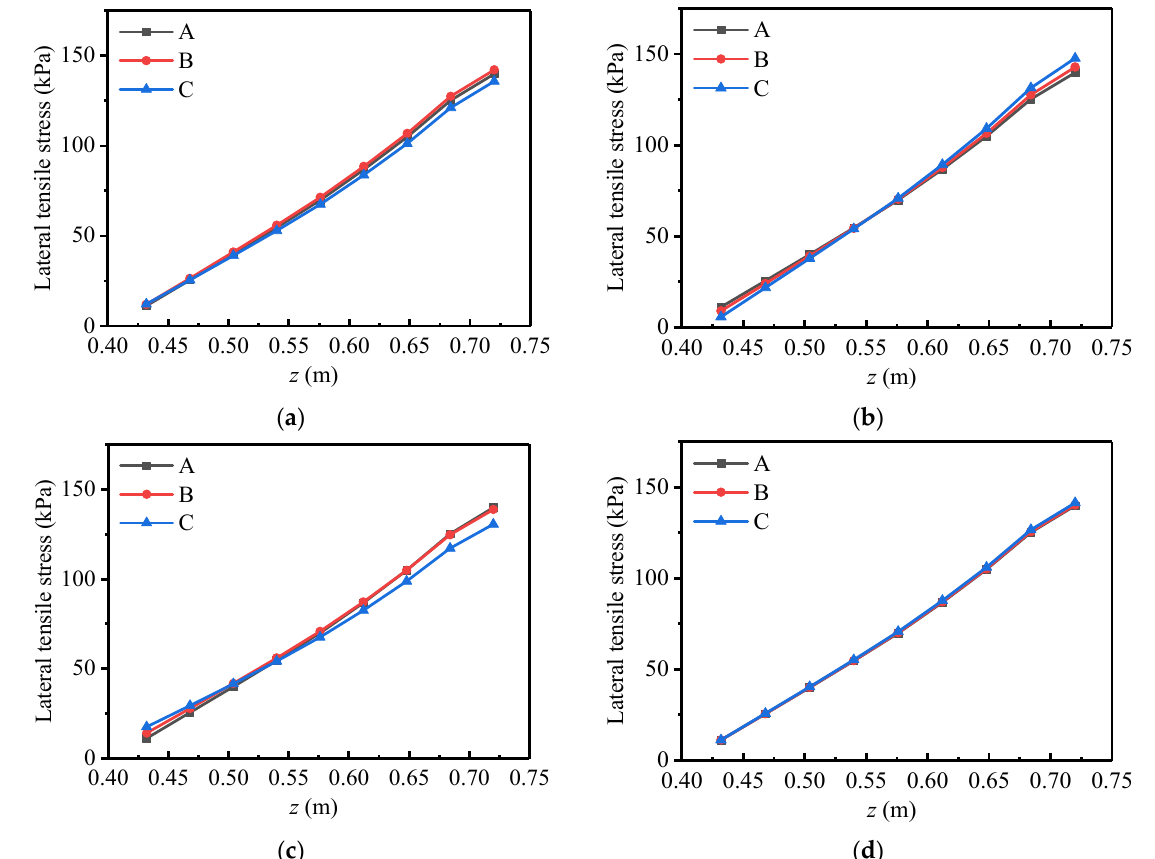
Figure 9. Lateral tensile stress under the anisotropy of different materials: ( a ) Anisotropy in all layers. ( b ) Anisotropy in the HMA layer. ( c ) Anisotropy in the semi-rigid base layer. ( d ) Anisotropy in the subgrade layer.